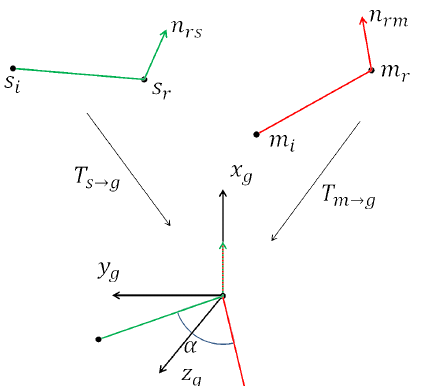
Figure 5. Transformation of corresponding points in model and scene. The transformation T m → g translates the model point m r into the origin and rotates its normal n m r onto the x -axis. T s → g does the same for the scene point pair. In many cases, s i and m i will be misaligned, and the rotation R x ( α ) around the x -axis with angle α is required to match